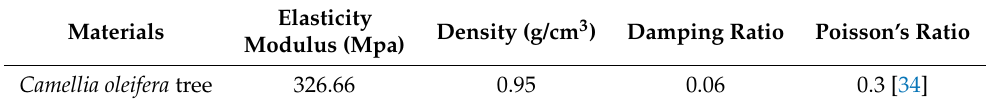
Table 2. Physical characteristics of Camellia oleifera tree.